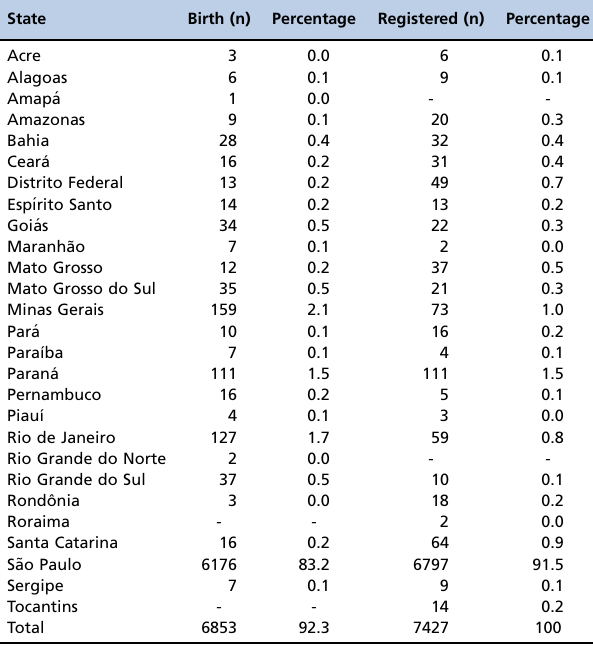
Table 3 - States where graduates of FMUSP were born and are registered.